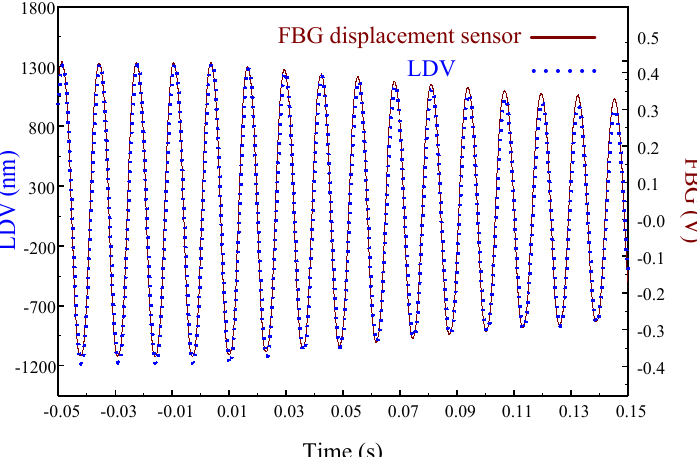
Figure 23. Free vibration of the smart cantilever beam excited at first resonant frequency (76 Hz) with a span of 0.2 s obtained from the FBG displacement sensor.